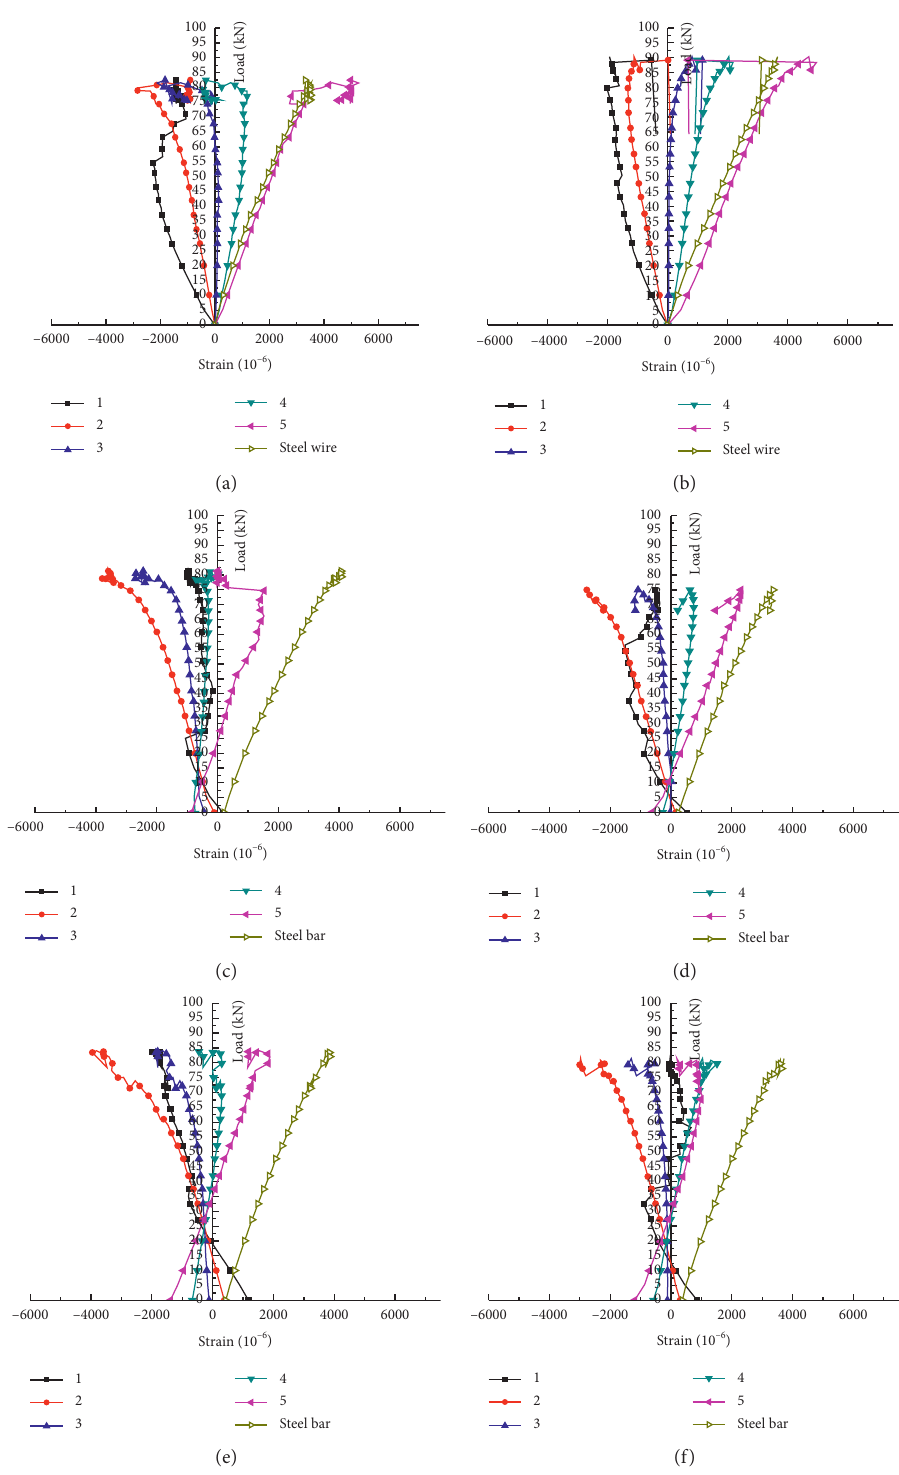
Figure 13: Load-strain curves of beams with six steel bars. (a) Load-strain curves of the L right span. (c) Load-strain curves of the L A5(2) left span. (d) Load-strain curves of the L A5(2) right span. (e) Load-strain curves of the L A8(2) left span. (f) Load-strain curves of the L A8(2) right